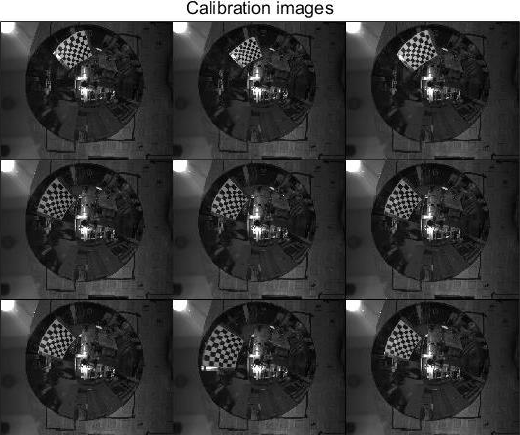
Figure 5. Feasible intersection of two solution spaces (left) and real image of mirror (right). Figure 16. Read picture names. Figure 16. Read picture names.